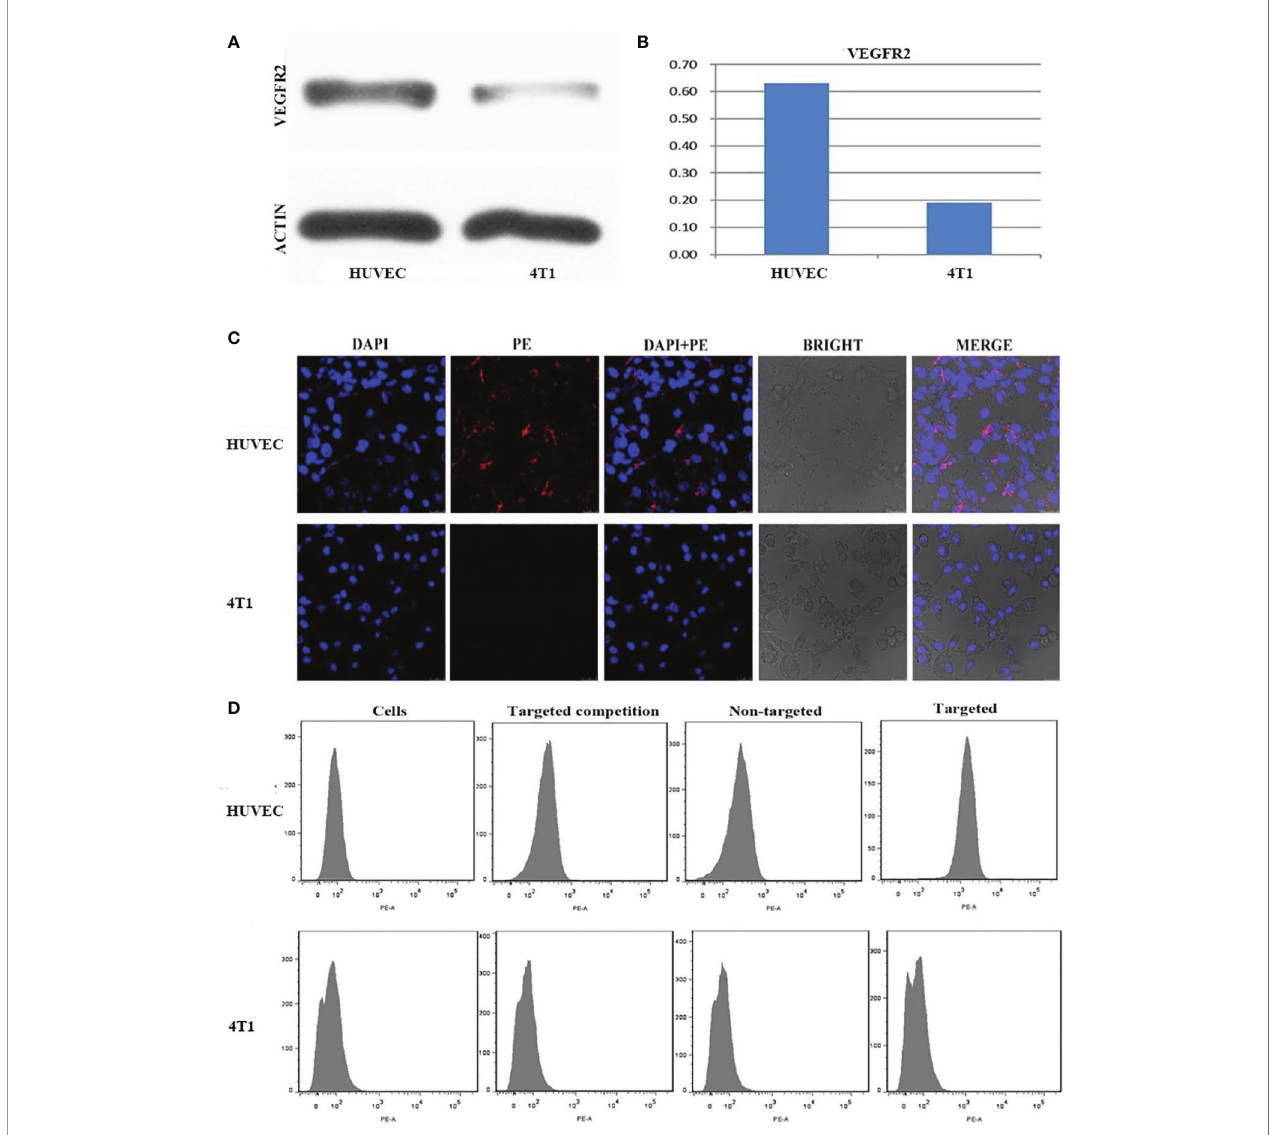
FIGURE 3 | (A) Western-blot images and quantitative analysis (B) of VEGFR2 membrane protein expression in HUVEC and 4T1 cells. (C) Confocal microscope images of HUVEC and 4T1 cells incubation with VEGFR2-PEG-HSNs-Fe. (D) FCM images of HUVEC and 4T1 cells in different groups (simple cells, targeted competition, non-targeted and targeted